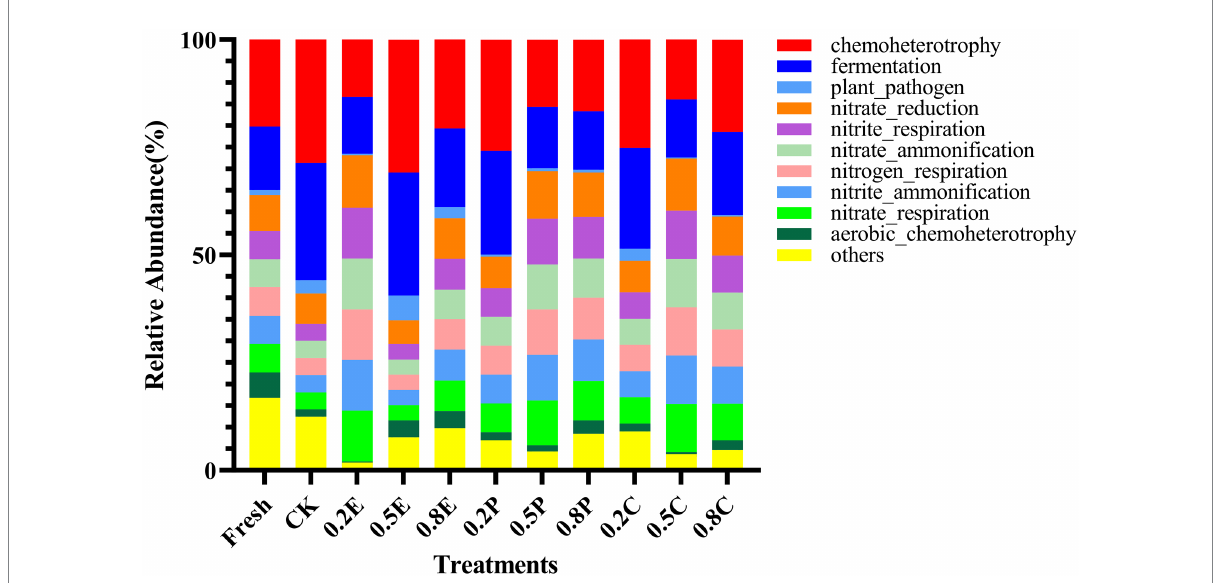
FIGURE 4 Function prediction of the bacterial community in paper mulberry silage on day 60. CK, control; E, EDTA; P, propionic acid; C, citric acid; 0.2, concentration of additive is 2 g.kg − 1 FM; 0.5, concentration of additive is 5 g.kg − 1 FM; 0.8, concentration of additive is 8 g.kg − 1